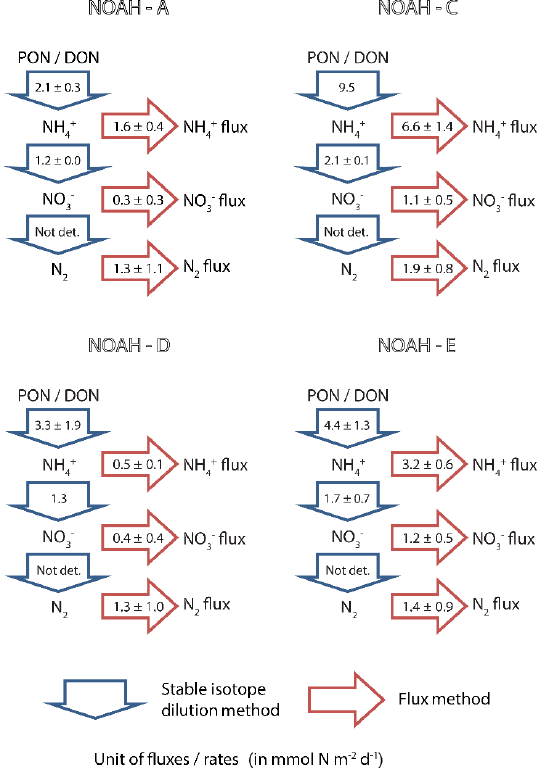
Figure 5. Benthic N-transformation rates (in mmolNm − 2 d − 1 ) of ammonification (NH + ) and nitrification (NO − ) as measured by 4 3 means of stable isotope methods (blue arrows). Simultaneously measured fluxes of ammonium (NH + flux), nitrate (NO − flux) and 4 3 N 2 (in mmolNm − 2 d − 1 ) as measured by the flux method (red ar-